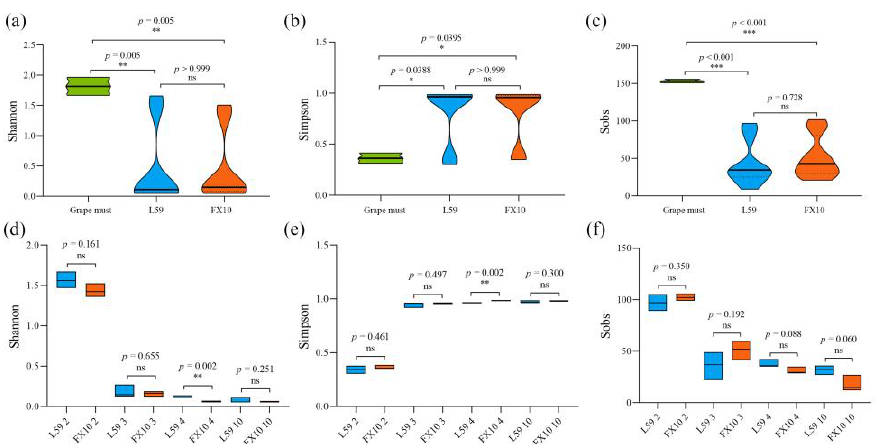
Figure 4. Alpha-diversity of the microbial community during the fermentation of Prince wine. Shan- non index ( a ), Simpson index ( b ) and Sobs index ( c ) of grape must and two groups of fermentation samples; Shannon index ( d ), Simpson index ( e ) and Sobs index of samples at different fermentation stages ( f ). Note: p -values are indicated with asterisks (*). * 0.01 < p < 0.05, ** 0.001 ≤ p < 0.01, *** p < 0.001; ns indicates no significance.